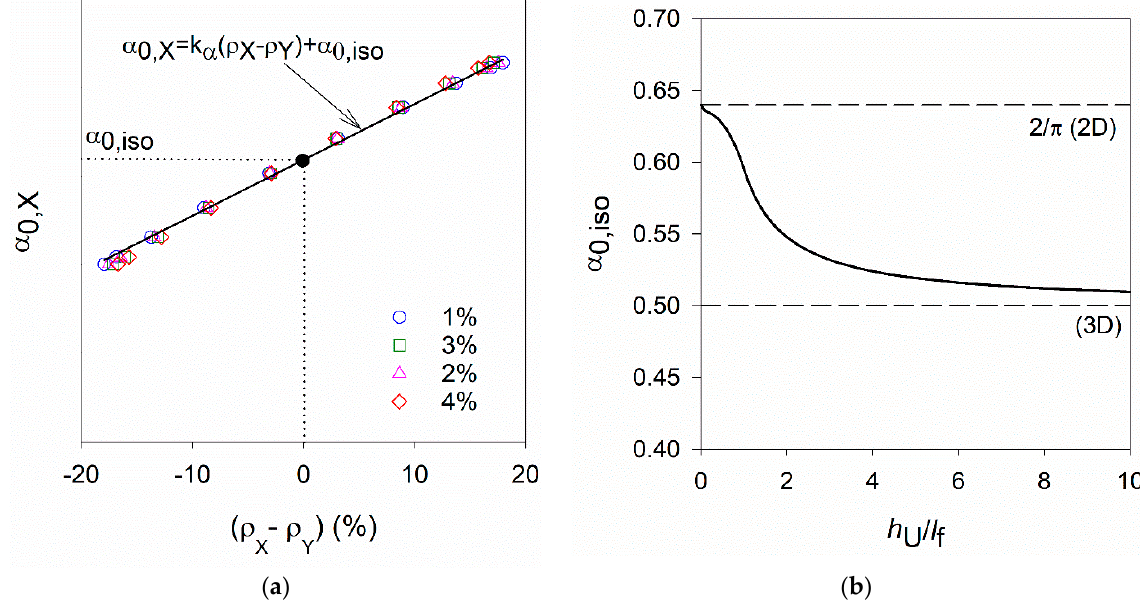
Figure 3. ( a ) Linear increase of α 0,X with ( ρ X − ρ Y ) ; ( b ) Variation of α 0,iso with h U /l f ratio [26].